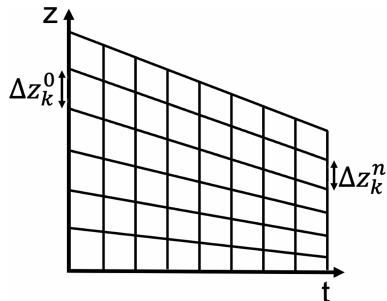
Figure 1. Computational mesh. The snowpack height varies with time, e.g., shrinks due to settling of the snow. This has to be in- corporated into the computational mesh, which undergoes defor- mation due to the downward movement of the free surface. The initially equidistant mesh does not uniformly change, which results in a mesh of varying node distances, so in general (cid:49)z 0 (cid:54)= (cid:49)z n (cid:49)z n k k + 1